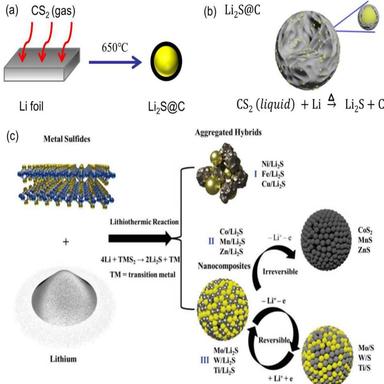
The schematic illustrating the reactions between Li and S-compounds to make Li2S-C via the reaction between (a) Li and CS2 gas or (b) liquid, and (c) Li2S-TM composites via the reaction between Li and TMS. Reproduced from Refs. with permission from Springer Nature, the American Chemistry Society, and Wiley.